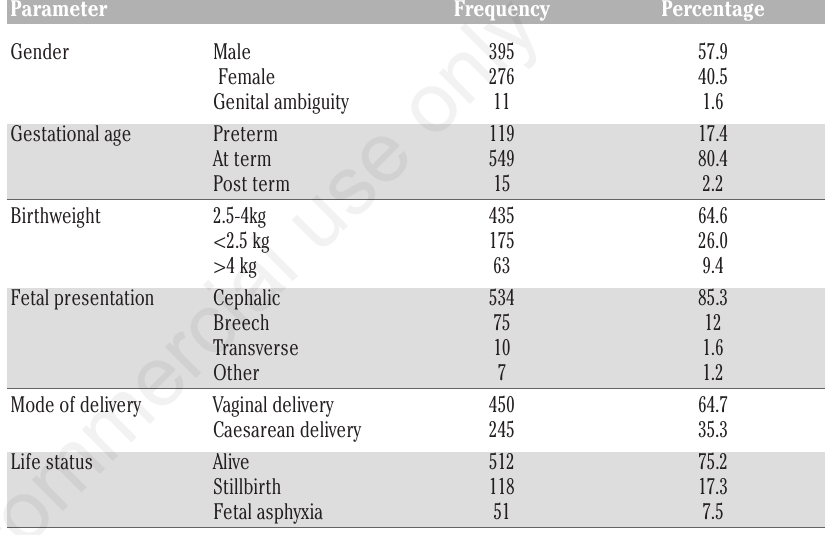
Table 3. Newborn’s characteristics.